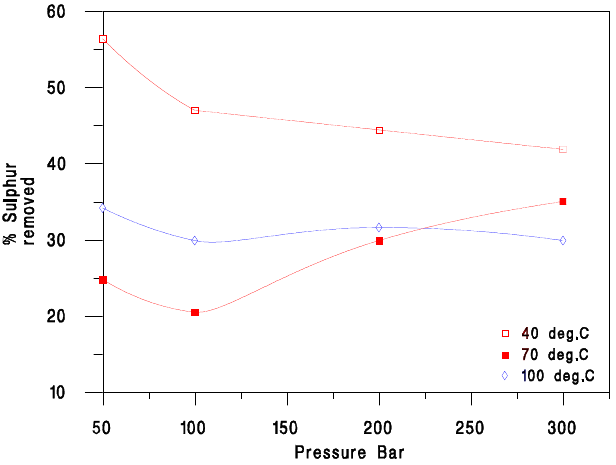
Figure 6. Effect of air pressure on organic sulphur removal for Silverdale coal.